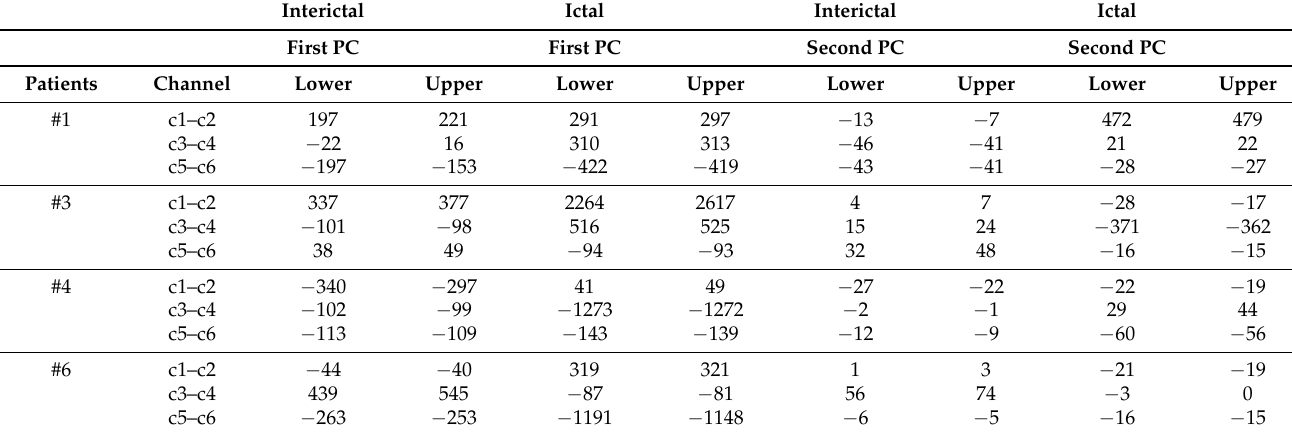
− 263 − 253 − 1191 − 1148 − 6 − 5 − 16 −